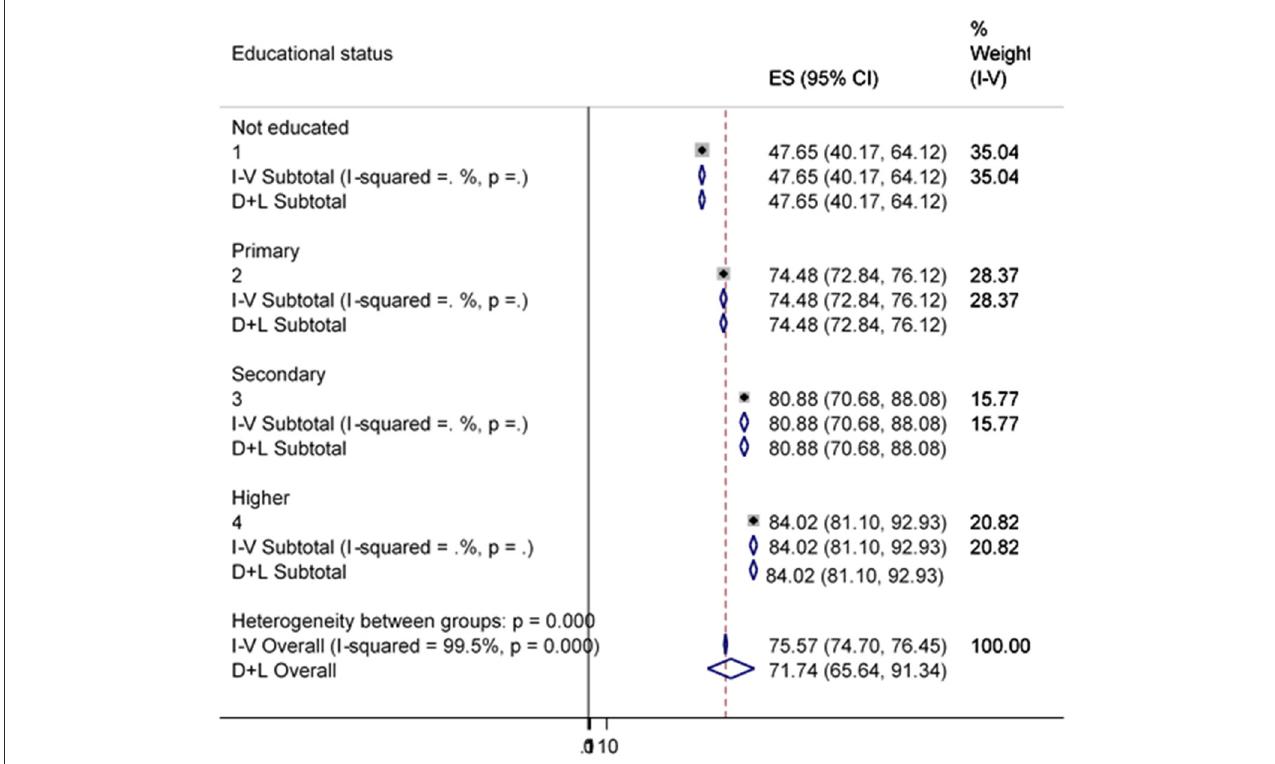
FIGURE5 Sub-group analysis of improved water source by Geographic